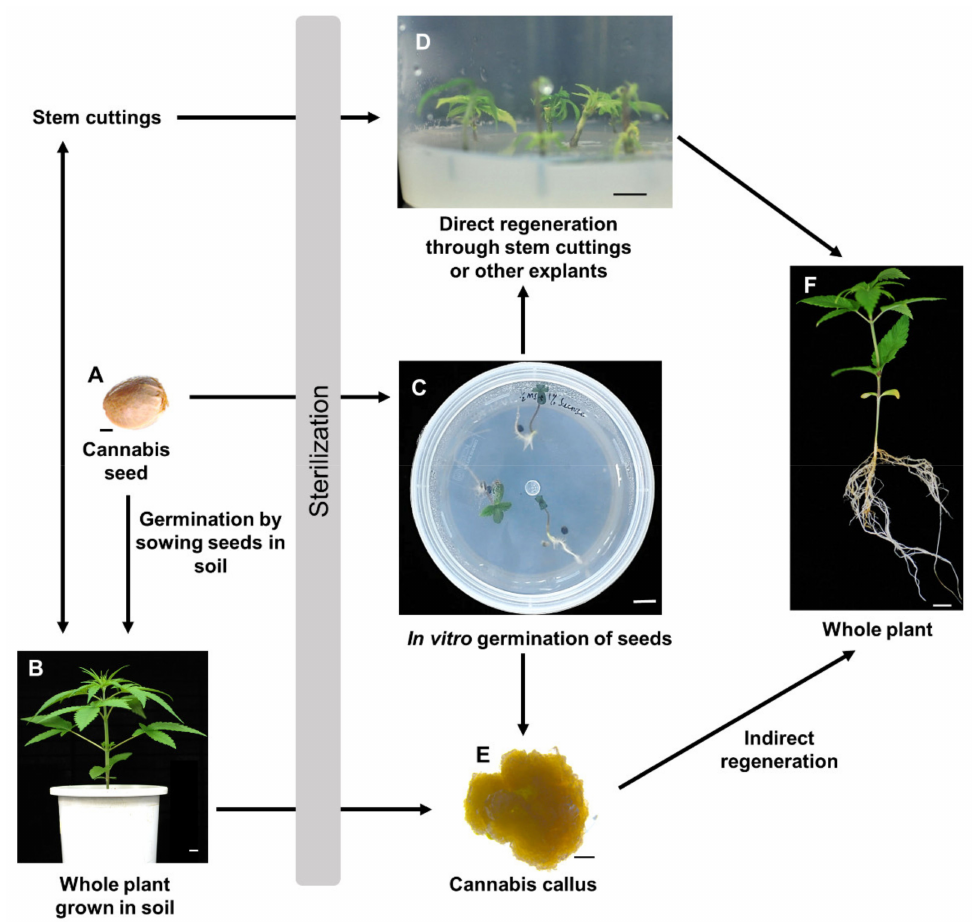
Figure 3. General procedure of Cannabis propagation. Germination of ( A ) Cannabis seeds can take place (Touret) in soil, as well as in sterile and optimal conditions to make ( C ) in vitro grown seedlings. Direct regeneration of Cannabis can be achieved through ( D ) stem cuttings in sterile conditions.